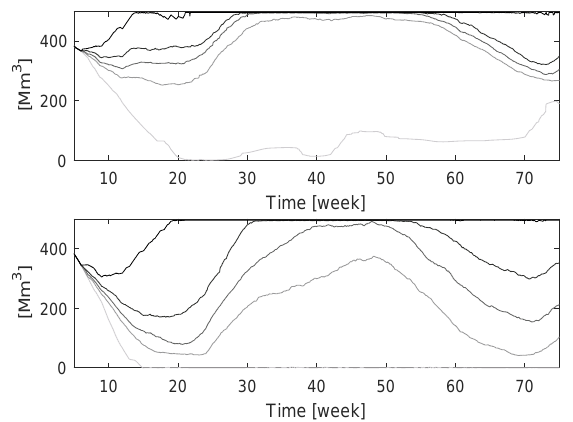
Figure 9. Percentile plot of reservoir trajectories for Reservoir 2. ( Top ) With Benders cuts and ( bottom ) with strengthened Benders